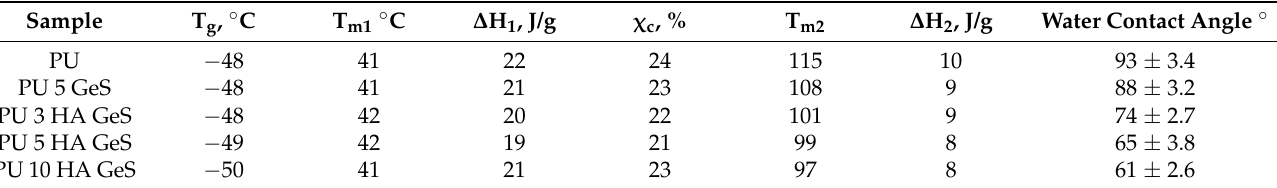
Table 1. Summary of DSC and water-contact-angle